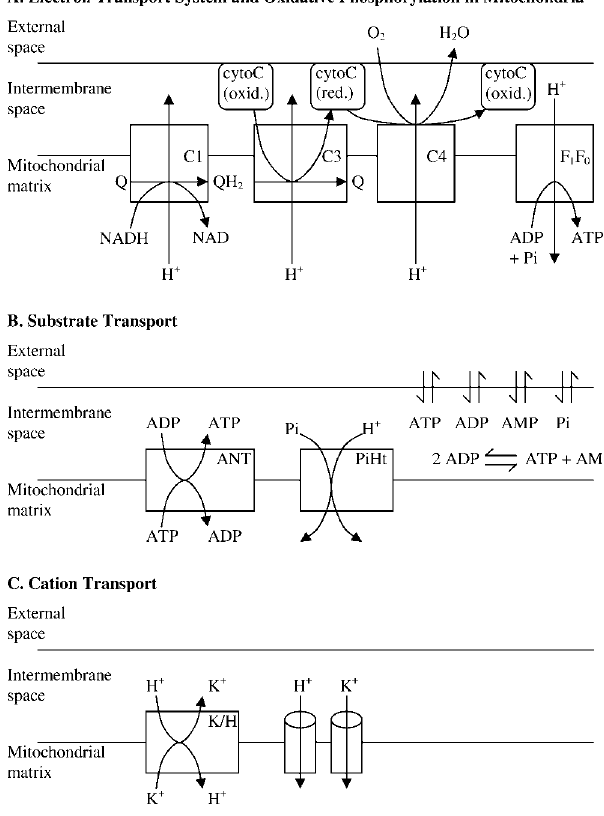
Figure 1. Illustration of the Components Included in the Model of Mitochondrial Oxidative Phosphorylation (A) The major components of the electron transport system, which transfers reducing potential from NADH to oxygen, and the F 1 F 0 ATPase, which transduces energy from proton motive force to ATP, are illustrated. Complexes I, III, and IV are labeled C1, C3, and C4, respectively. (B) The substrate transport process included in the model is shown, including the ANT and PiHt on the inner membrane, and passive permeation of ATP, ADP, AMP, and phosphate across the outer membrane. The AK reaction in the IM space is shown. (C) Transporters for hydrogen and potassium ions on the inner membrane, including K þ /H þ antiporter and passive proton and potassium fluxes, are included. It is assumed that these cations rapidly equilibrate across the outer membrane. DOI: